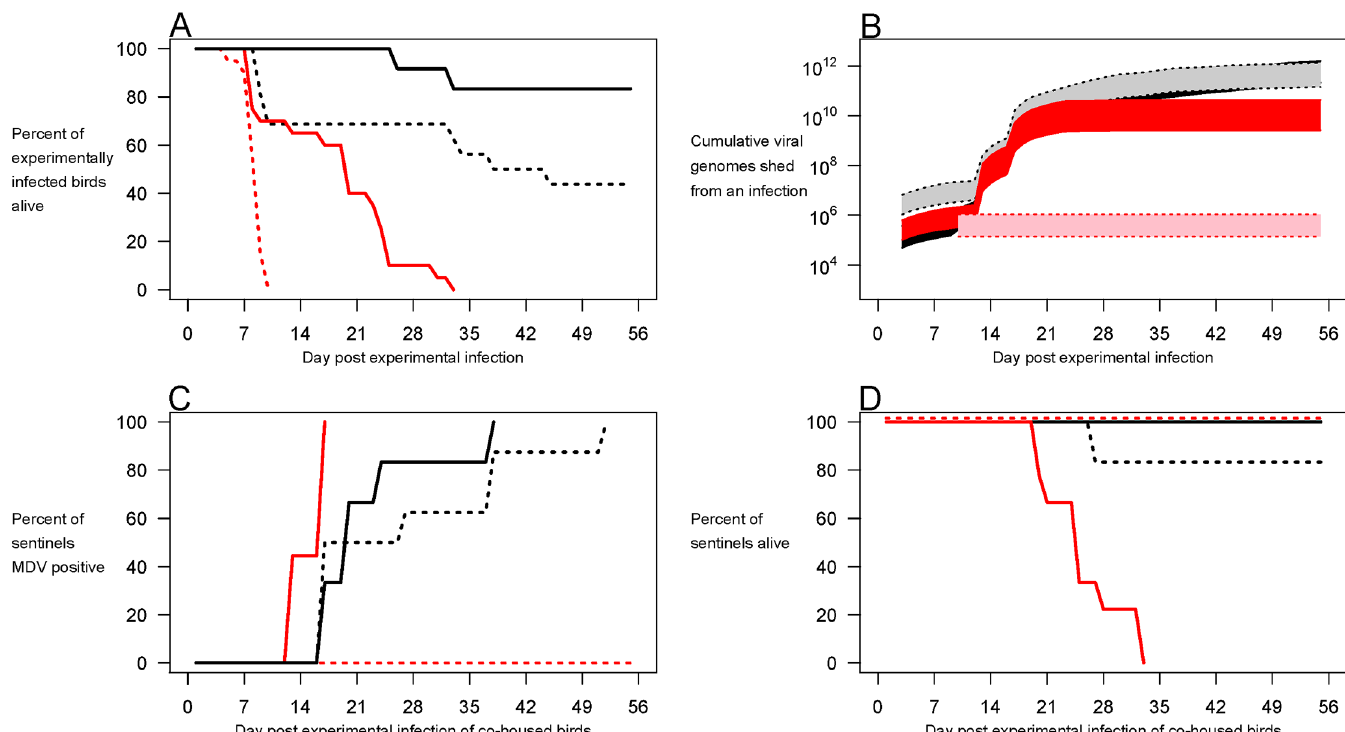
Fig 3. Maternal vaccination enhances viral shedding and onward transmission of hyperpathogenic MDV. Experiment 3. Groups of ten unvaccinated chicks produced by hens that were Rispens-vaccinated (solid lines) or not (dotted lines) were infected with viral strains HPRS-B14 (black) or 675A (red) and cohoused with sentinels of the same maternal antibody status. Maternally derived antibodies prolonged the survival of experimentally infected birds ( A ) and enhanced the amount of virus shed into the environment by the hyperpathogenic strain ( B ), making possible the infection of sentinels with the most virulent strain ( C ), which led to their death ( D ). Shaded regions represent 95% c.i. for unvaccinated (light) and vaccinated (dark). Raw data can be found at http://dx.